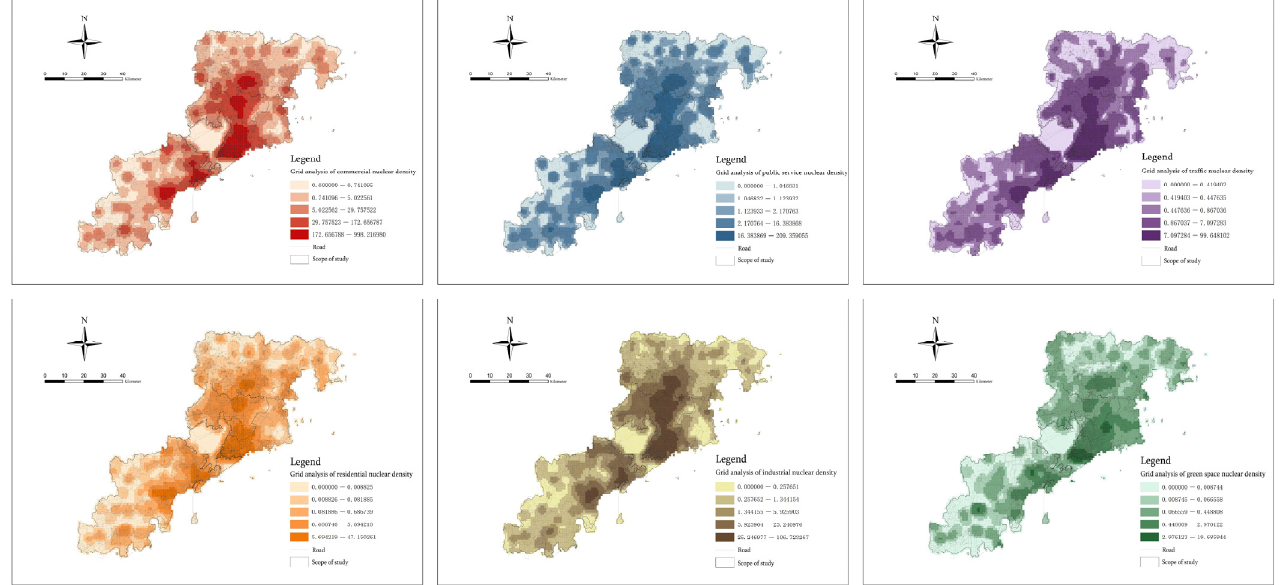
Figure 10. Kernel density estimation analysis of POI data representing six functional categories.